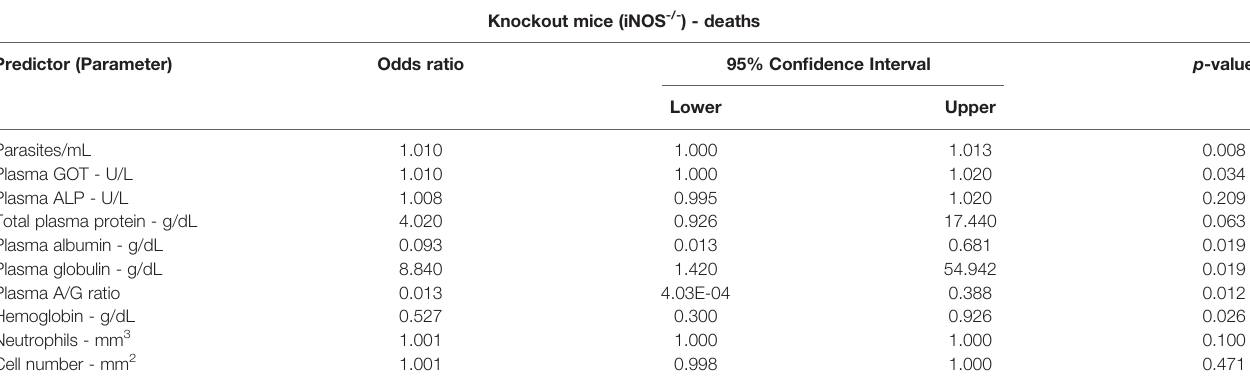
TABLE 3 | Binomial logistic regression model to estimate parameters associated with the outcome of death in knockout mice (iNOS -/- ) infected with different inoculum concentrations of Trypanosoma cruzi ( “ Y ” strain) in the acute phase (after 12 days of infection). Knockout mice (iNOS -/- ) -